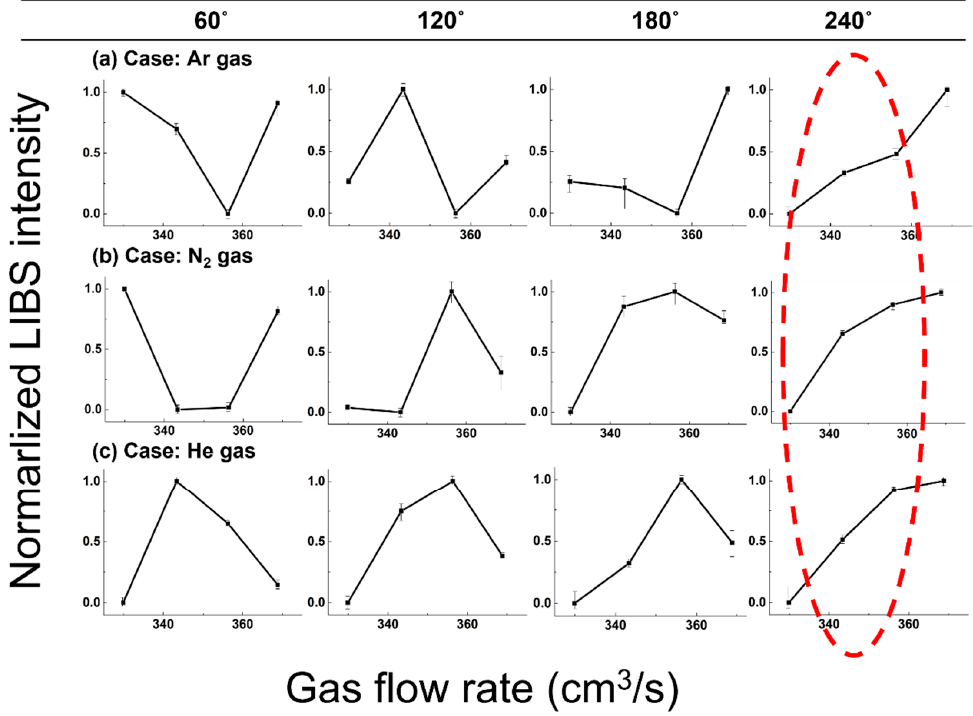
Figure 12. LIBS signal intensity by flow rate for various inlet port directions; ( a ) Ar, ( b ) N 2 , and ( c ) He gas.